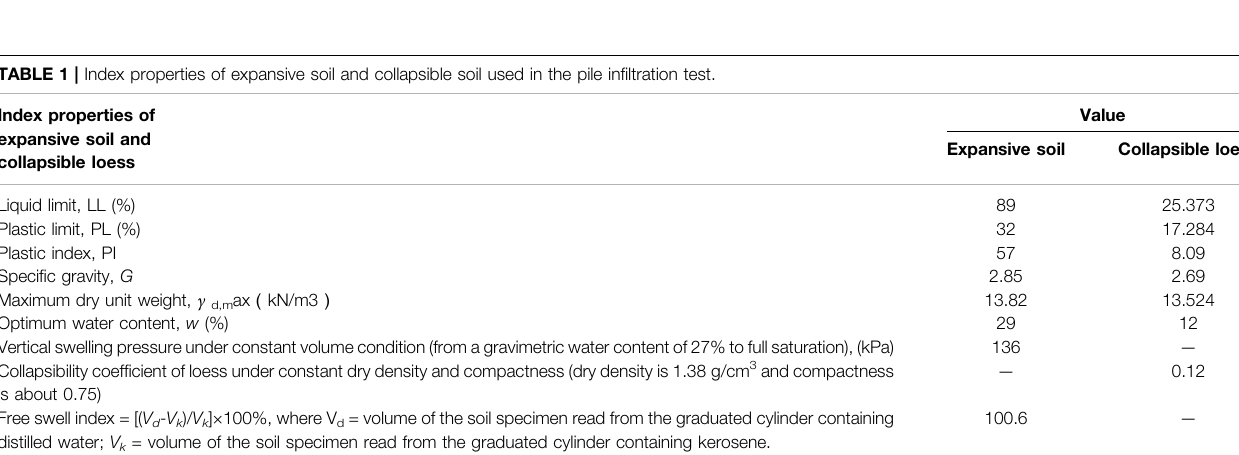
FIGURE 2 | Experimental setup of the pile in fi ltration test. [ (A) Expansive soil. (B) Collapsible soil].